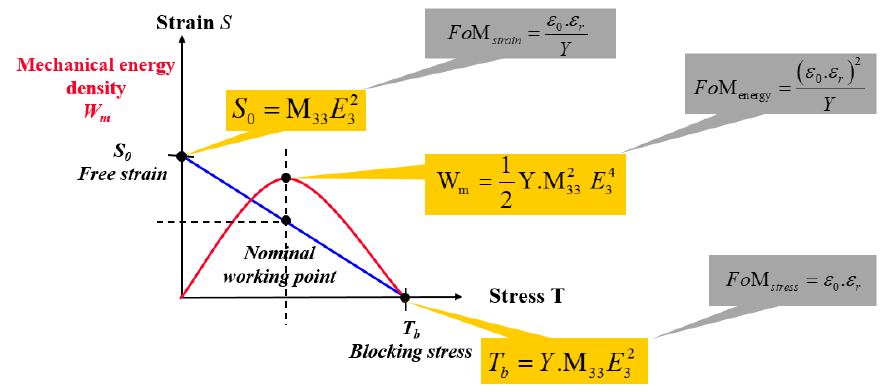
Figure 2. Pertinent parameters and figures of merit for an electroactive polymer.